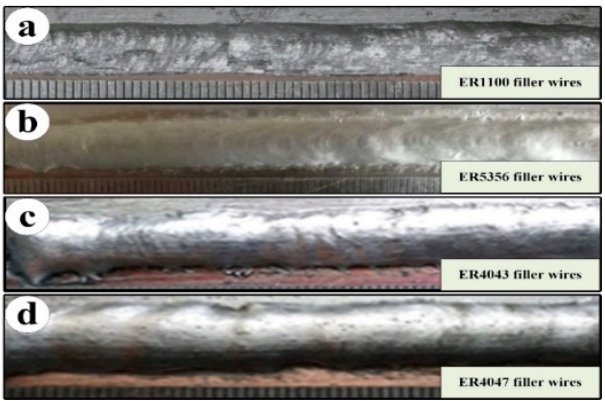
Figure 4. Surface appearances of joints at di ff erent filler wires ( I main = 60 A). ( a ) ER1100 filler wires; ( b ) ER5356 filler wires; ( c ) ER4043 filler wires; ( d ) ER4047 filler wires.